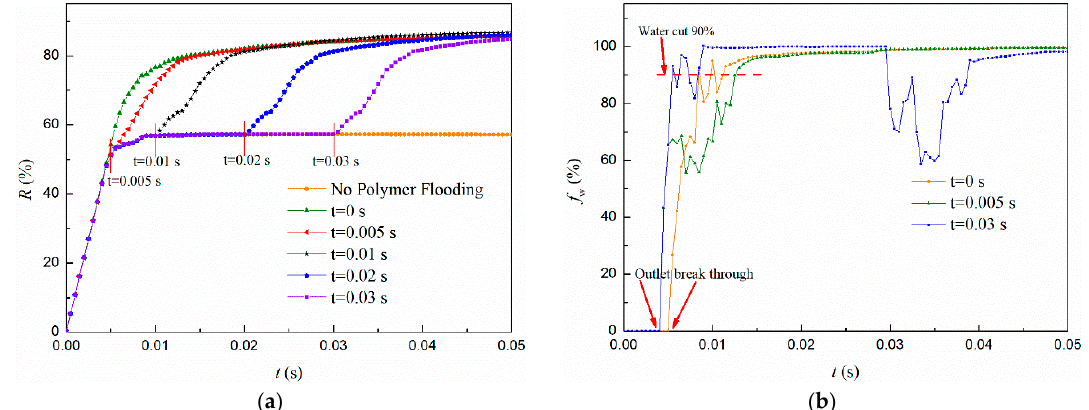
Figure 14. The oil recovery and water cut at the outlet when the polymer solution is injected at different times: ( a ) oil recovery rates (Y-axis is oil recovery rate, % and X-axis is time, s) and ( b ) water cut curves (Y-axis is water cut, % and X-axis is time, s).